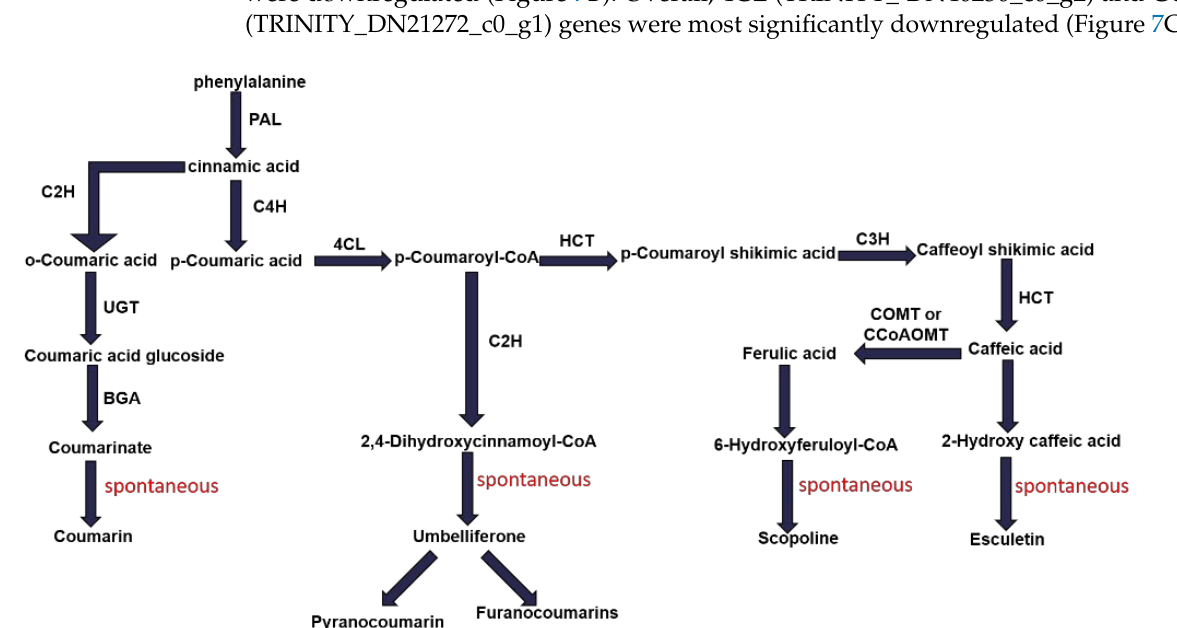
Figure 6. Expression patterns of genes involved in coumarin biosynthesis.